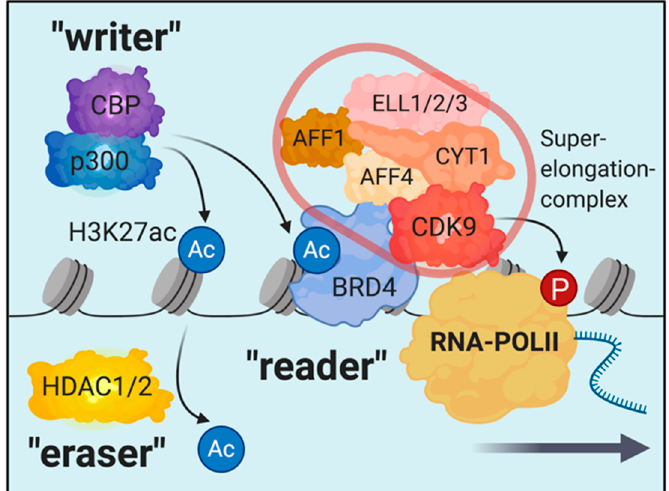
Figure 1. Schematic illustrating the concept of writers, erasers, and readers on the example of the H3K27ac-mark. Multiprotein-complexes are recruited and / or associate with reader proteins for locus specific chromatin localization. In this example, the superelongation-complex, which is required for RNAPolII activation, associates with BRD4.